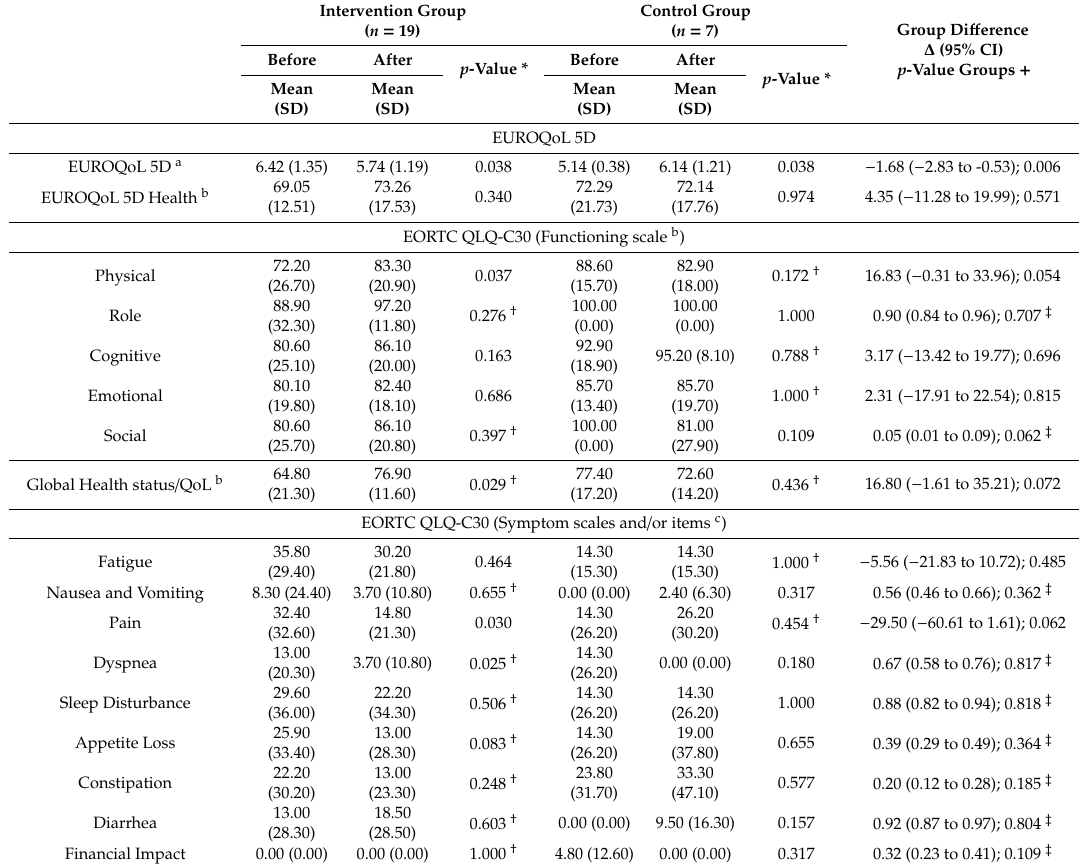
Table 5. Results of health-related quality of life domains by